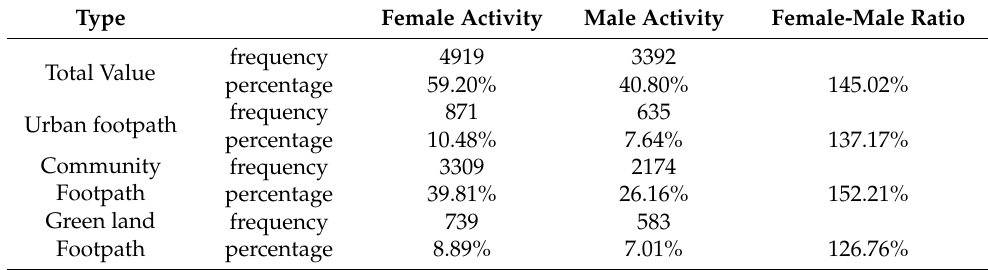
Table 2. Distribution of residents’ JA